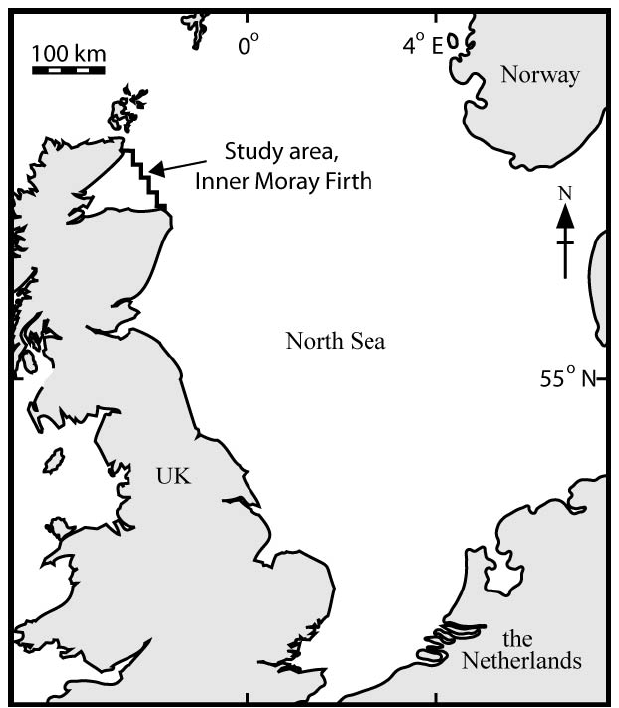
Figure 1. Location map of study area.